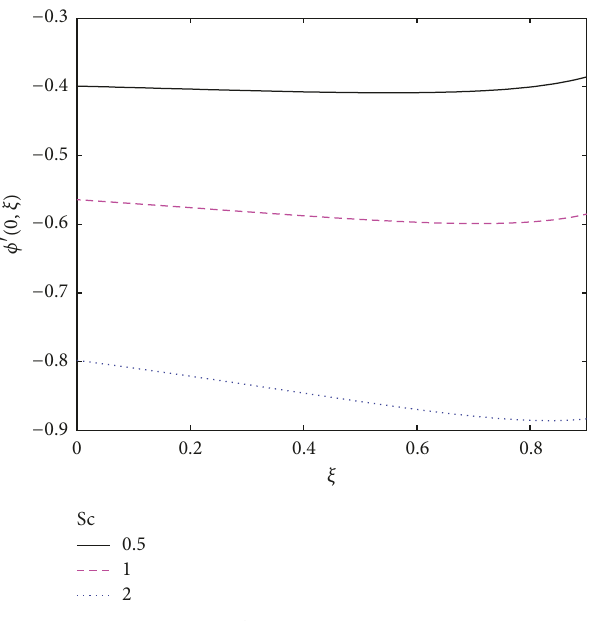
Figure 28: Effect of Sc on 𝜙 󸀠 (0,𝜉) ( 𝜎 = 𝛾 = 0.5, Pr = 3, 𝜆 = 1, ℏ = −0.5